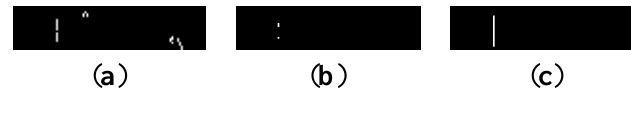
Figure 13. ( a ) Binary image of wavelet coefficients; ( b ) Image after erosion; and ( c ) Image after 2